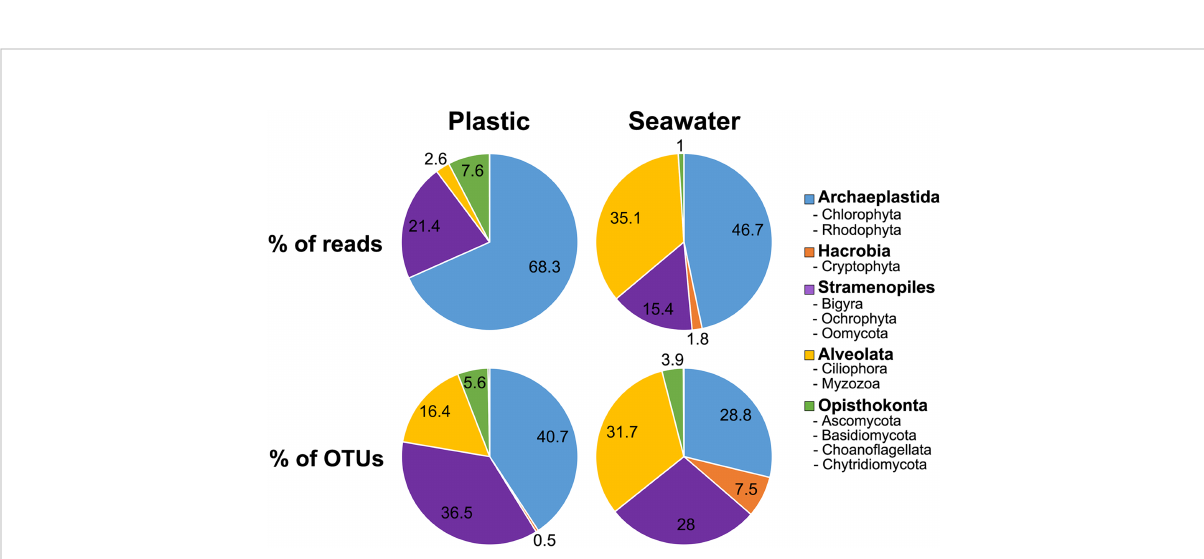
FIGURE 5 Pie charts illustrating the relative proportion of the number of operational taxonomic units (OTUs) and the number of reads in the taxonomic supergroups detected in plastic and seawater